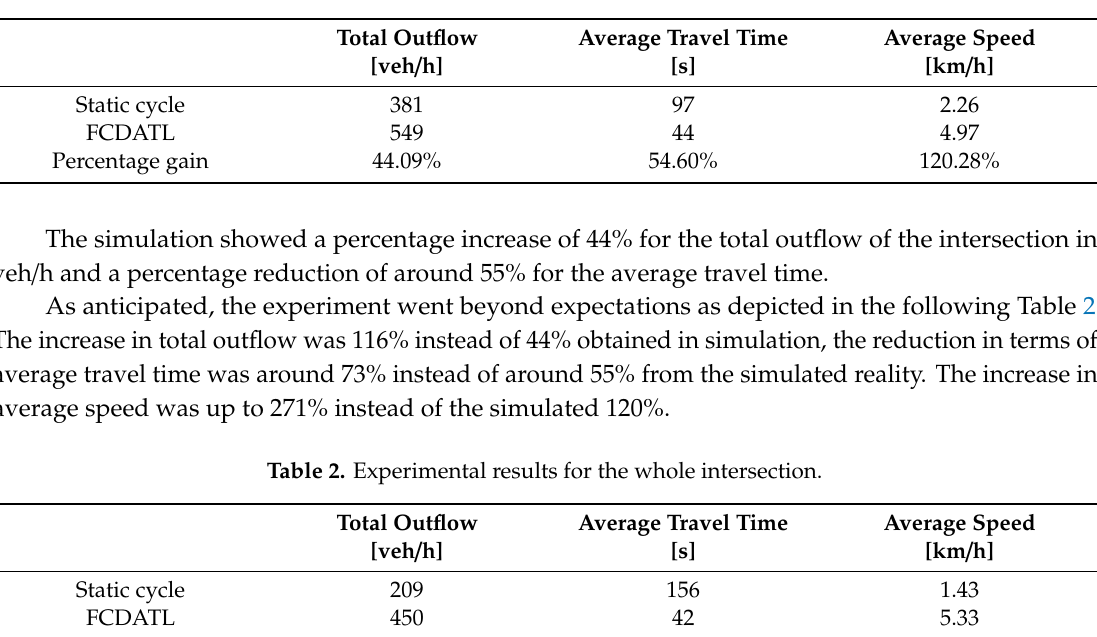
Table 1. Simulation results for the whole intersection.